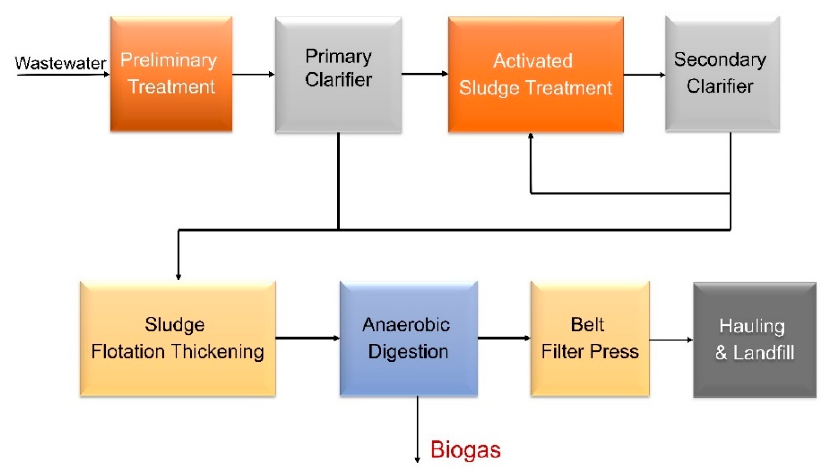
Figure 4. Process Flow Diagram of a WWT Facility as Modeled in CapdetWorks. Bioengineering 2020 , 7 , x FOR PEER REVIEW